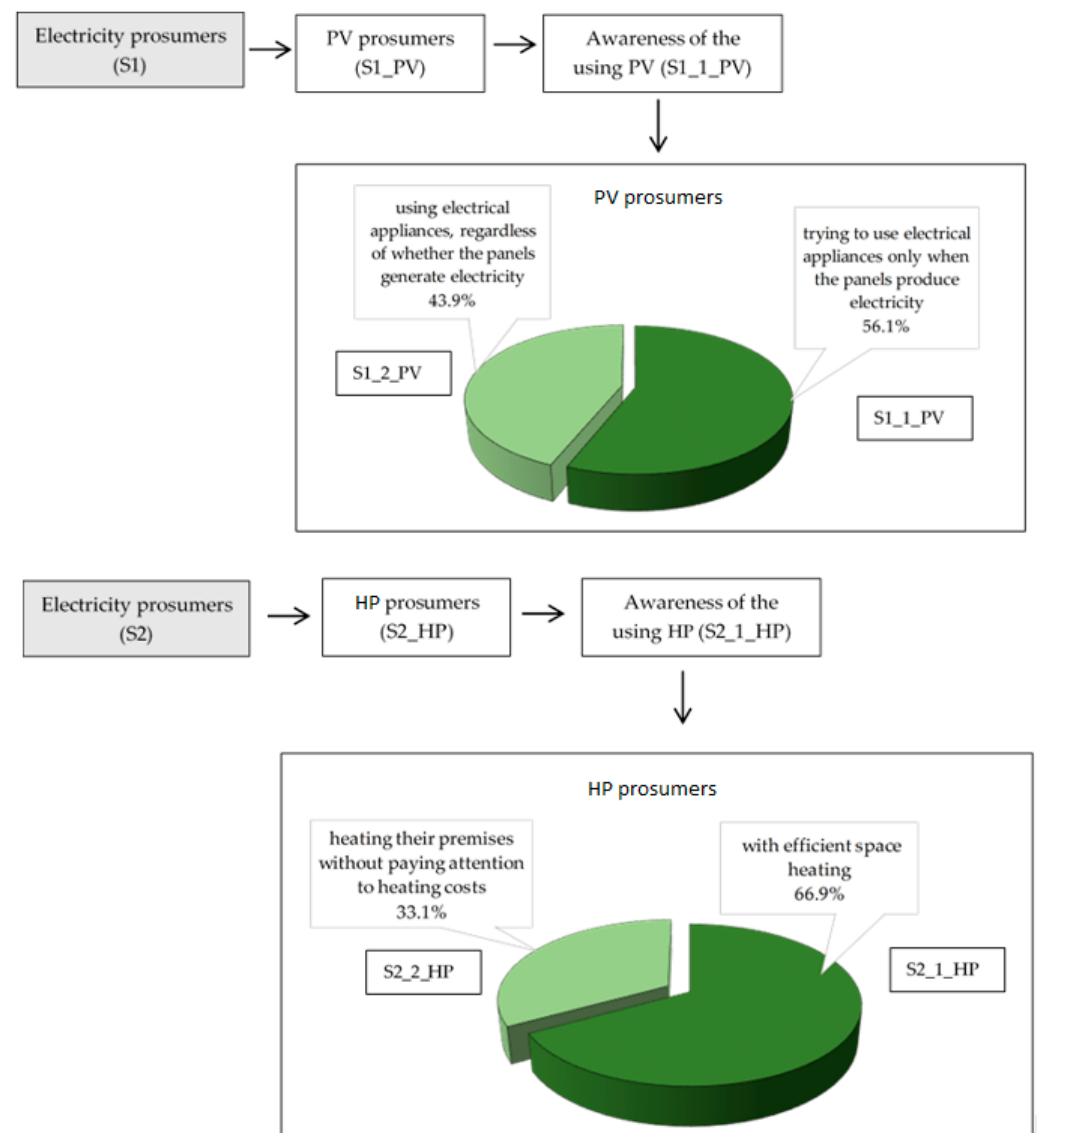
Figure 3. Behaviors of PV and HP prosumers: distribution of responses from Table 4. Source: own research.